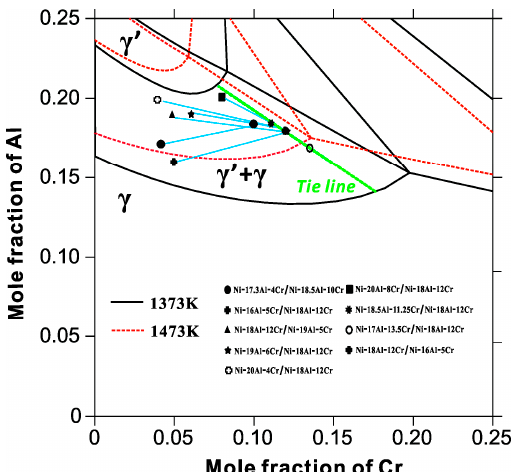
Figure 1. Isothermal sections at 1373 and 1473 K in Ni-rich region of ternary Ni–Al–Cr system calculated according to the thermodynamic parameters reported by [48]. The initial alloy compositions for γ + γ '/ γ + γ ' bond coat/substrate systems are appended in the figure, while the green line indicates the tie line of γ + γ′ two-phase region.